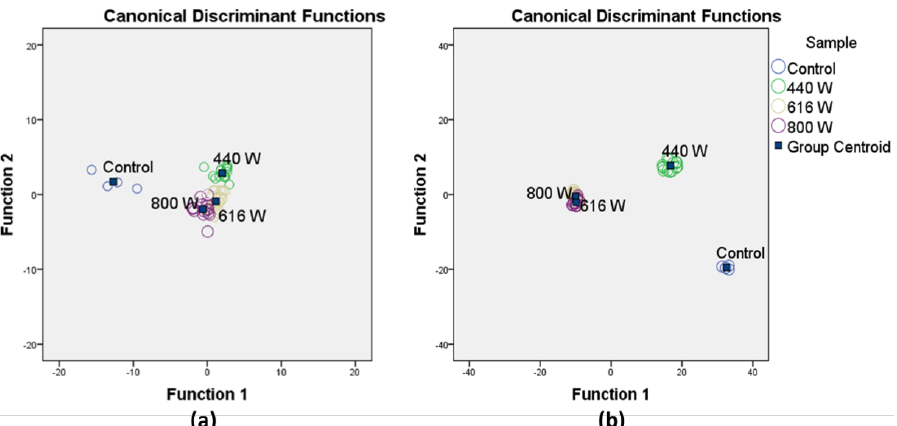
Figure 1. Graphical plot of the results from the stepwise canonical analysis of saffron samples obtained by microwave dehydration at different powers and control samples, before ( a ) and after three months of storage ( b ). After the dehydration process, the control sample was separated from microwave dehydrated stigmas by function 1 (71.4% of variance) and function 2 (92.8% of cumulative variance) (Figure 1a). Function 1 depended on trans -4-GG, trans -3-Gg, and trans -5-nG mainly, and function 2 depended on trans -4-GG, trans -5-tG, and trans -2-G primarily. Sim- ilar analysis was performed after three months of storage, and in this case, control sample and stigmas dehydrated at 440 W were separated from the rest of the treatments by func- tion 1 (82.9% of variance) and function 2 (99.5% of cumulative variance) (Figure 1b). In this case, function 1 depended on cis- 3-Gg, trans- 4-GG, and trans- 2-G mainly, and function 2 depended on trans- 3-Gg, trans- 5-tG, and trans- 5-nG, principally. After three months of storage, a higher separation of the treatments at 440 W due to cis -3-Gg, mainly, was ob- served. Considering Tables 3 and 5, cis -3-Gg content decreased at 440 W after storage, while the isomer trans -3-Gg increased. It seems that the dehydration process at this power produces a less stable isomerization than the rest of the powers studied. Therefore, the microwave dehydration process separated saffron obtained from the stigmas dehydrated by “toasting”, and this separation was more pronounced after three months of storage, due mainly to the content of crocetin esters and more specifically to the most abundant crocins. 3.2. Commercial Quality of Microwave-Dehydrated Saffron The commercial quality of saffron is classified into three categories established by ISO 3632 [7]. This standard indicates that the highest quality category must be composed of saffron with a minimum value of 200 of 𝐴 1 𝑐𝑚1% 440 nm, 70 of 𝐴 1 𝑐𝑚1% 257 nm, and a 𝐴 1 𝑐𝑚1% 330 nm value between 20 and 50. Results of UV-vis spectrophotometric analyses of the control and saffron dehydrated at different powers and time lapses are shown in Table 6.